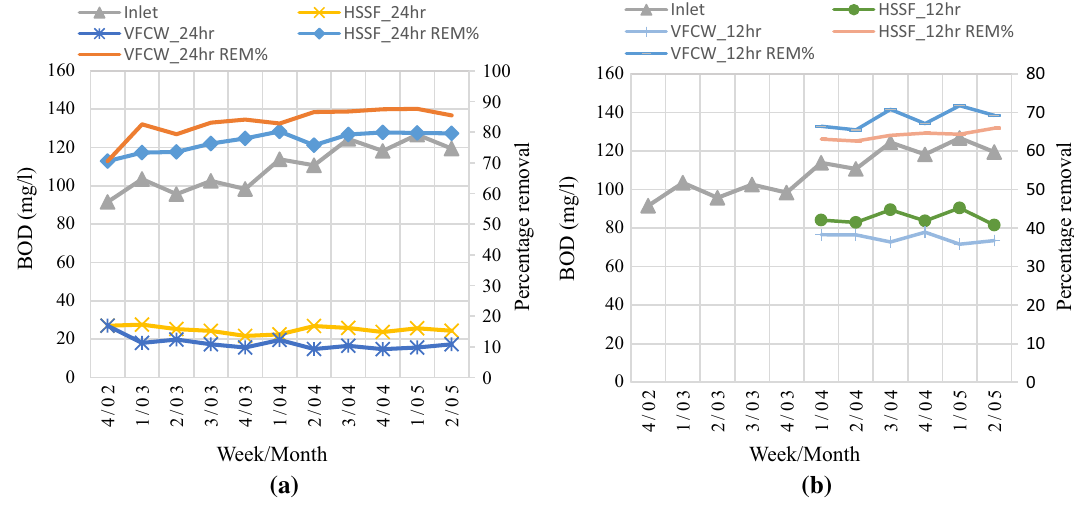
Fig. 4 a BOD5 influent, effluent concentration and percentage removal of HSSF-CW and VFCW for 24-h HRT, b BOD5 influent, effluent con- centration and percentage removal of HSSF-CW and VFCW for 12-h